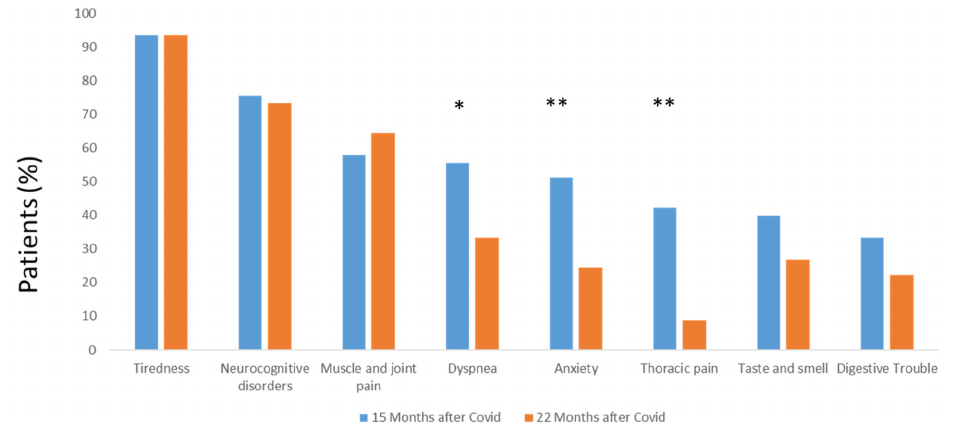
Figure 4. Symptoms frequency before and after coordination team-proposed support. *: p < 0.05, **: p < 0.01. Results were analyzed by McNemar’s test.